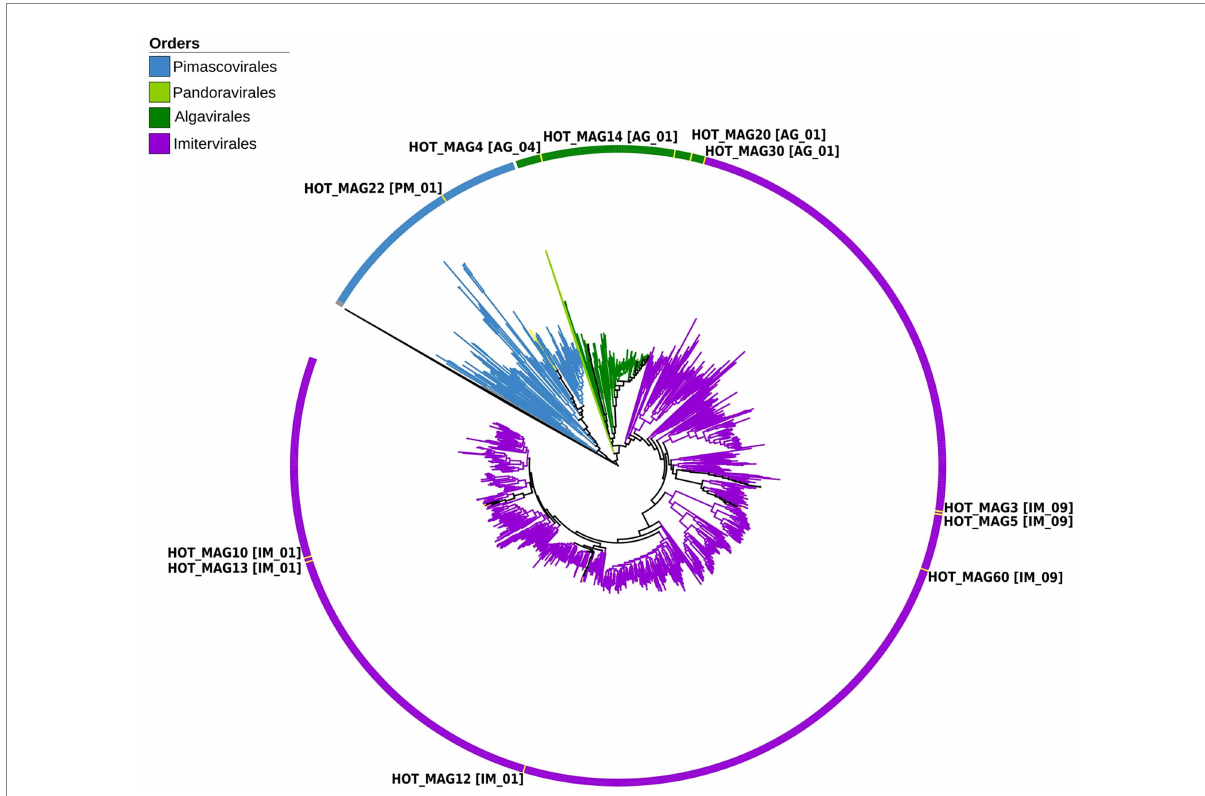
FIGURE 1 Multi-locus phylogenetic tree of the 11 MAGs together with 1,381 reference genomes from the Giant Virus Database. The phylogenetic tree was constructed using 7 maker genes that are highly conserved in giant viruses (see Materials and methods for details). According to the constructed phylogenetic tree, HOT_MAG22 belongs to the order Pimascovirales [PM_01]. HOT_MAG4 [AG_04], HOT_MAG14 [AG_01], HOT_MAG20 [AG_01] and HOT_MAG30 [AG_01] clustered within the order Algavirales . The rest of the MAGs, HOT_MAG3 [IM_09], HOT_MAG5 [IM_09],